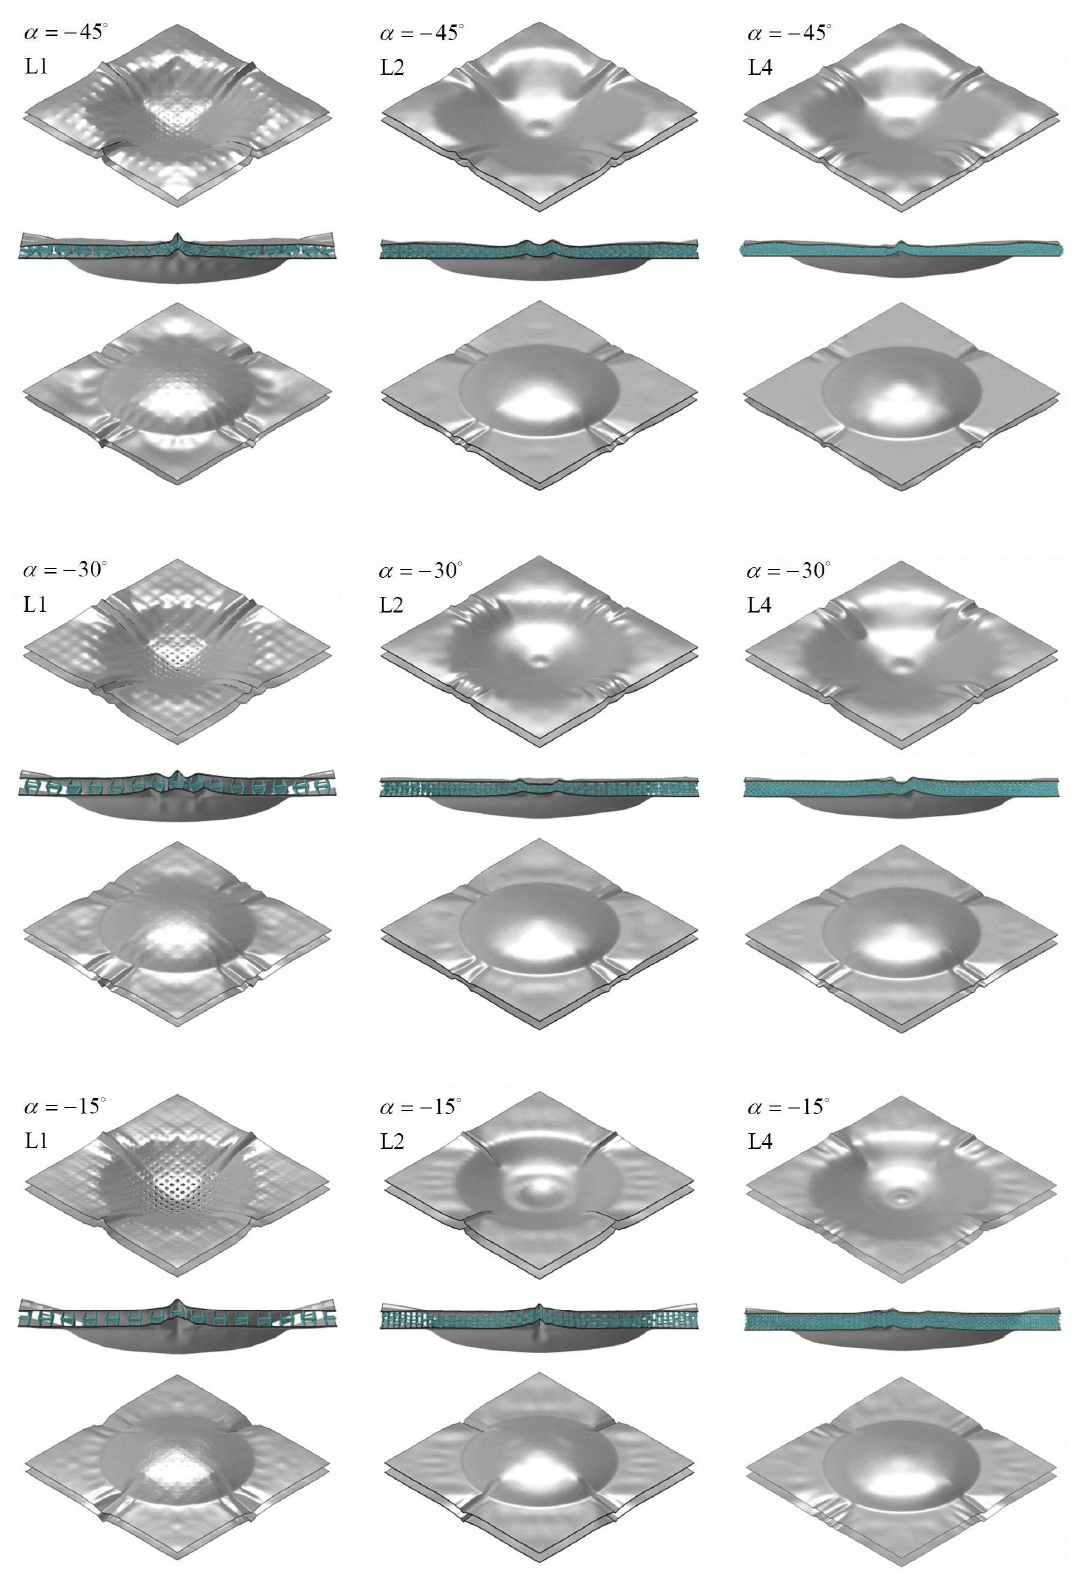
Figure A9. Deformation states of the top and bottom sides for 3D lattice, one- and multi-layered, auxetic cores with cell angle α < 0 ◦ subjected to air-blast loading (t = 0.6